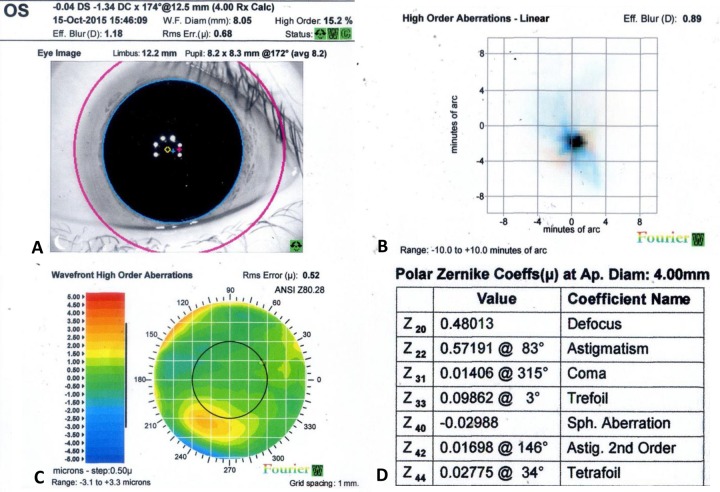
Example to explain data collection: Left eye of a 5-year-old girl who underwent iDesign measurements after cycloplegia.(A) Eye image and refraction error power (diopter), wavefront reconstruction based on Zernike polynomials for all-order aberrations root mean square (RMS) error (μ), higher-order aberrations (HOAs) rate (%), all-order aberrations effective blur (diopter), and quality check signal light; (B) Point spread function and HOAs effective blur (diopter) using Fourier reconstruction; (C) HOAs Wavefront error map and HOAs RMS error (μ) using Fourier Reconstruction; (D) Zernike table and Polar Zernike coefficients (μ) at aperture diameter of 4 mm.